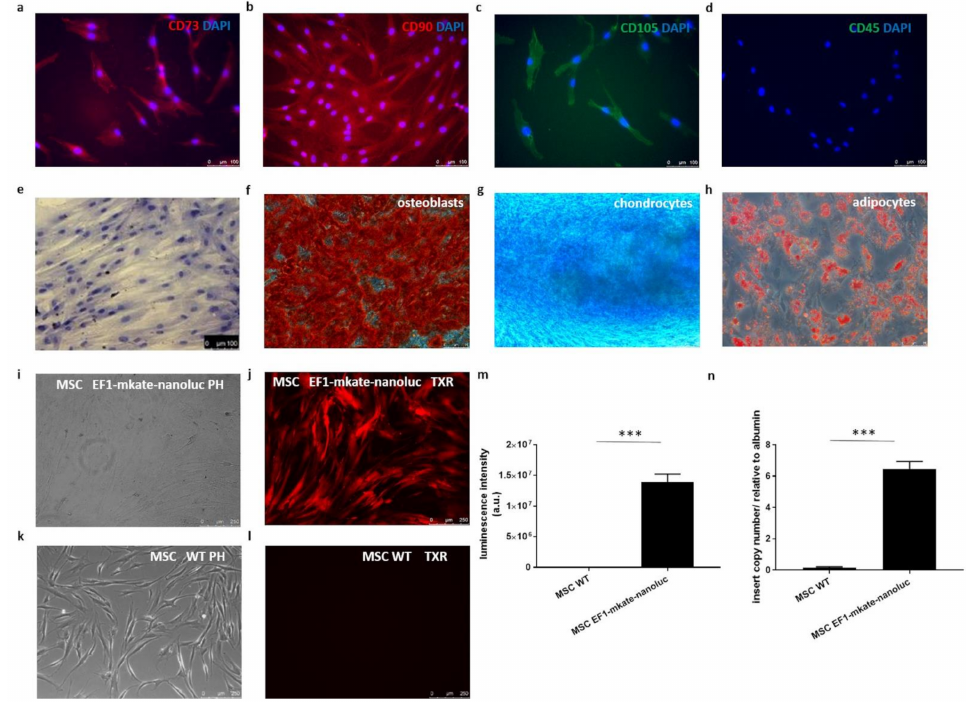
Figure 3. Mesenchymal stem cells characteristics. ( a ). Cells stained positively for-CD73, ( b ). CD90 ( c ). CD 105 and ( d ). negatively for CD 45, nuclear dye DAPI (blue), scale bar = 100 µ m. ( e ). Staining of MSC with eosin and hematoxylin. Multipotent character of the cells shown as the ability to differentiate into osteoblasts, chondrocytes and adipocytes was confirmed with ( f ). Alcian red, ( g ). Alizarin blue and ( h ). Oil red staining, respectively, scale bar = 50 µ m. ( i , j ). in vitro imaging of mesenchymal cells transduced with EF-1-mkate-nanoluc lentiviral promoter reporter system vs. ( k , l ). Non transduced cells–WT. ( m ). Luminescence intensity of EF-1-mkate-nanoluc-transduced mesenchymal stem cells vs. untransduced controls (WT); measurements were performed in triplicate, *** p < 0.001. ( n ). EF1-mkate-nanoluc insert copy number in MSC cells (6.4 copies) vs. untransduced control (MSC WT) relative to albumin, *** p <